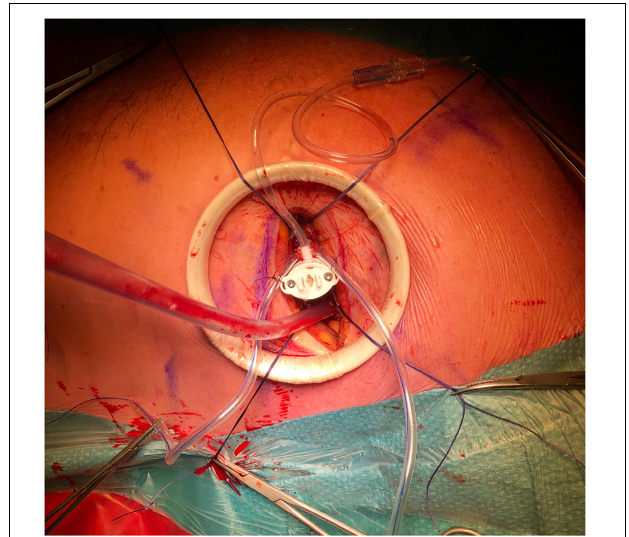
FIGURE 4 | The set-up for Harpoon Beating Heart Mitral Valve Repair through a left anterolateral thoracotomy, as performed in the Sint Antonius Hospital Nieuwegein. The left shoulder and elbow are slightly flexed dorsally. A soft tissue retractor is used without additional rib spreading. Four pericardial stay sutures are placed. The hemostatic introducer is inserted and secured with two concentric purse-string